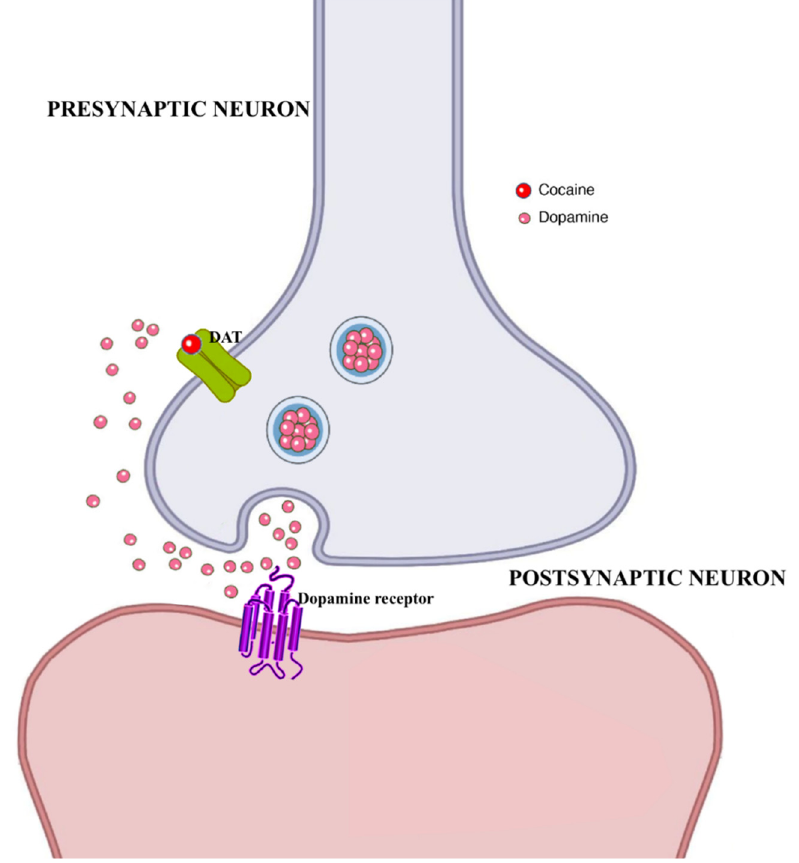
Figure 3. Molecular mechanisms associated with cocaine effects . Abbreviations: DAT: dopamine transporter.